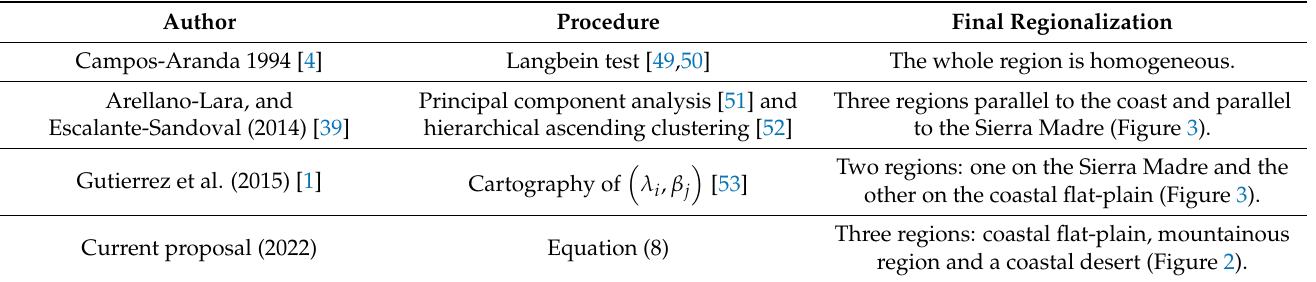
Table 1. Techniques used for the delimitation of homogeneous